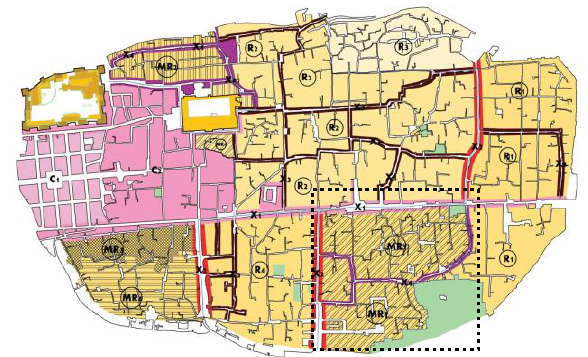
Figure 14. Detailed Guideline Plan of the Old City of